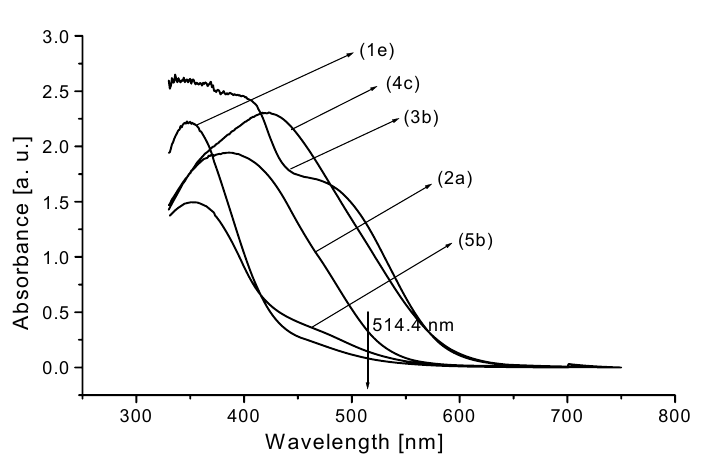
Fig. 1 Representative absorption spectra of azo functionalized polymers as films cast on glass. An arrow indicates the position of the 514.5 nm line used in recording. Curve labeling corresponds to that introduced in Table 1.